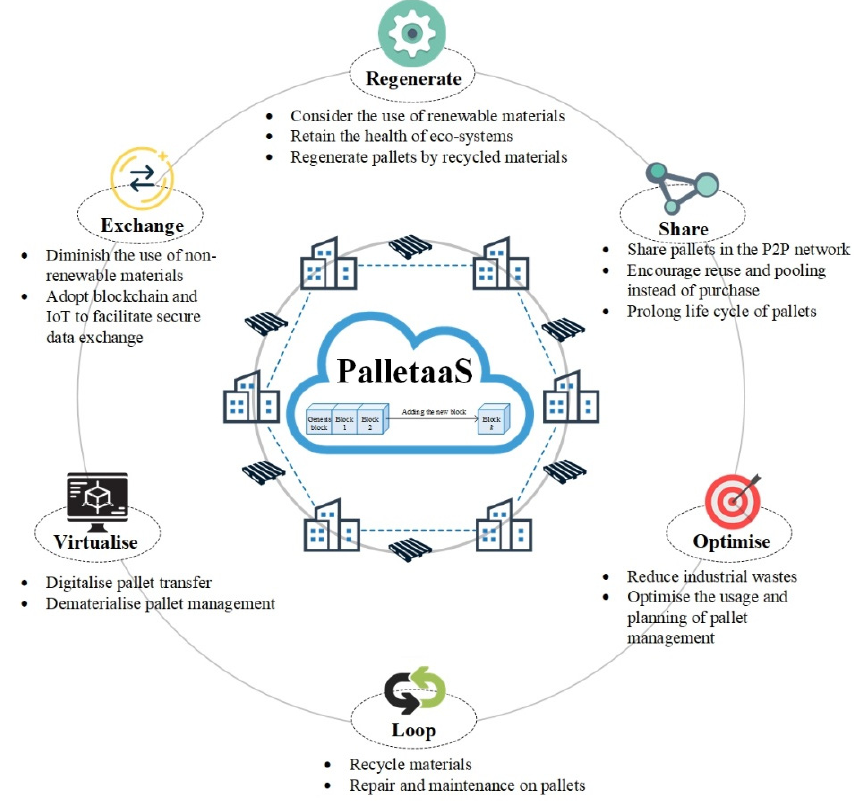
Figure 6. Graphical illustration of applying ReSOLVE framework in PalletaaS.